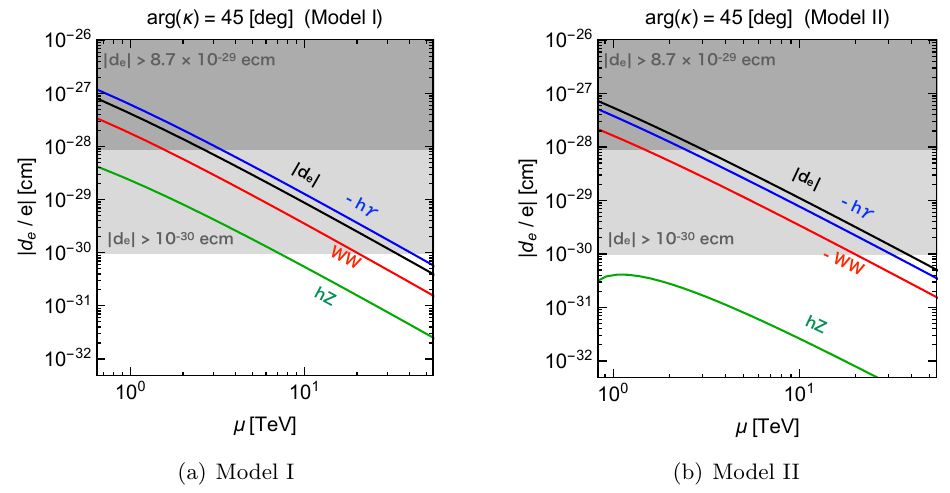
Figure 11 . Each contribution to the electron EDM as a function of the fermion mass parameter (cid:22) . Black, red, blue, and green lines show the total, WW , h(cid:13) , and hZ contributions, respectively, with the sign of each contribution indicated explicitly. We set (cid:22)